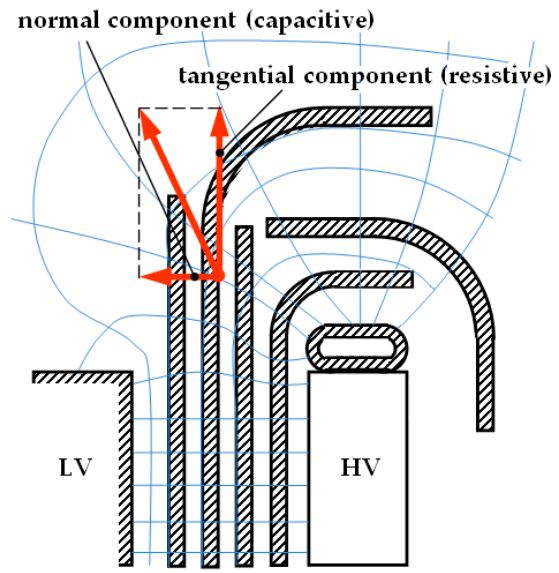
Figure 2. Electric field distribution at the upper end of the transformer winding, based on [6].